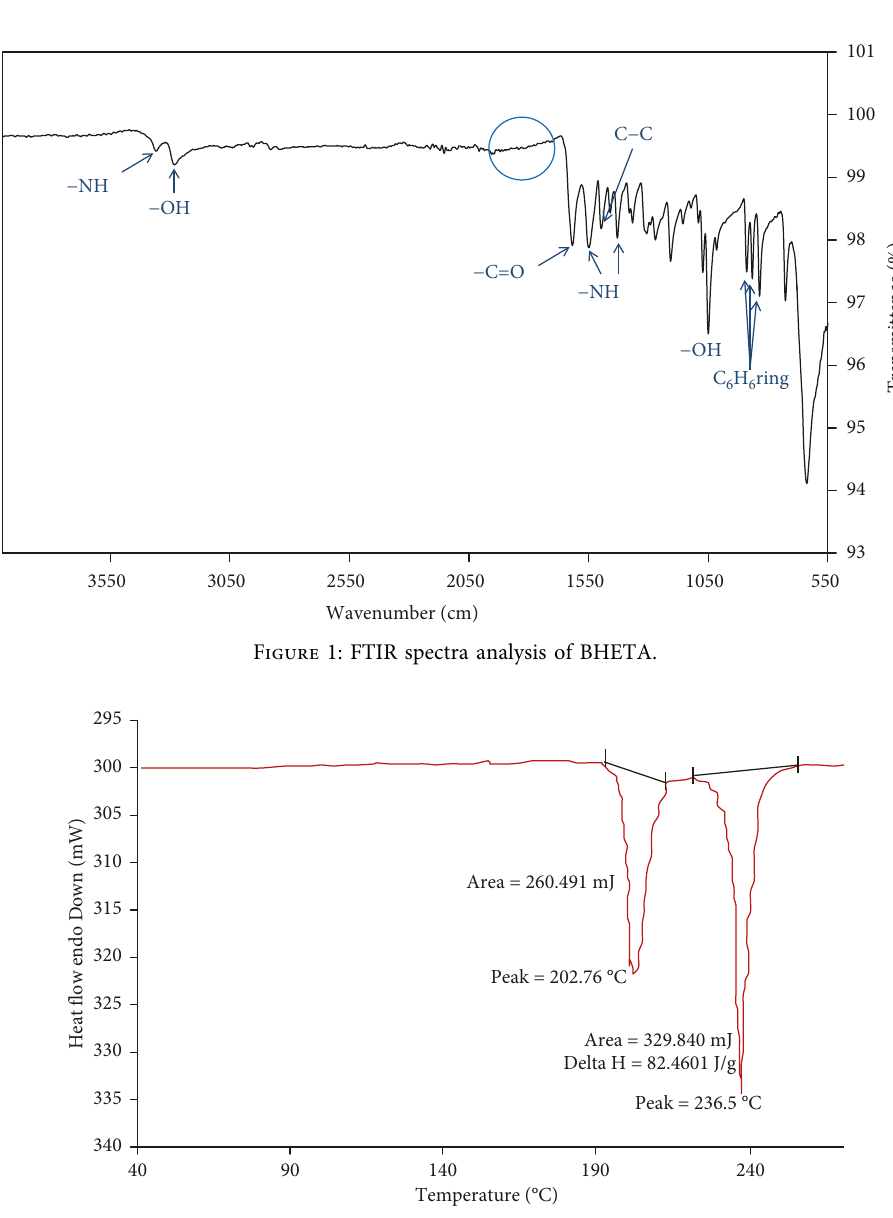
Figure 2: DSC analysis of BHETA.